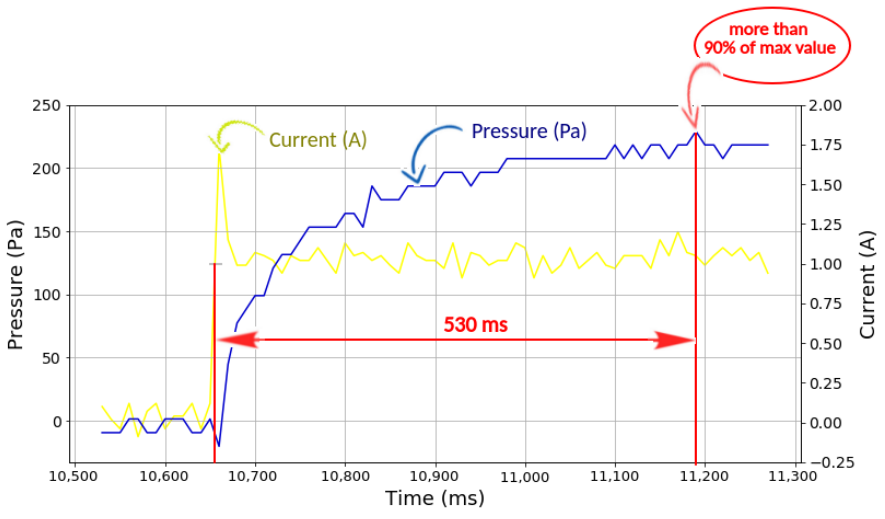
Figure 10. Changes in MRFs pressure at an input current of 1.00